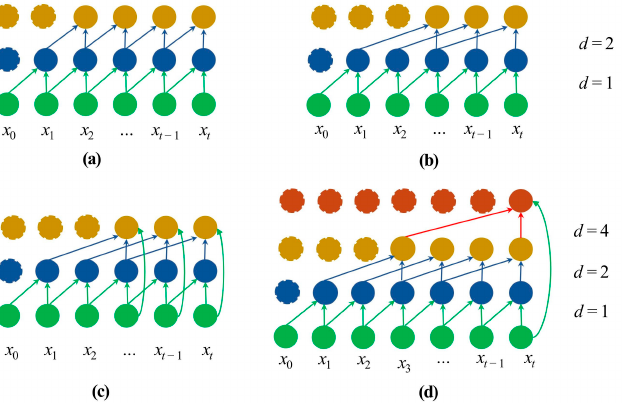
Figure 2. The architectural components in a TCN module. ( a ) Causal convolution with kernel size k = 2. ( b ) Dilated convolution with dilation factors d = 1, 2. ( c ) Residual block. ( d ) A schematic of the TCN module with dilated causal convolution and a residual block.